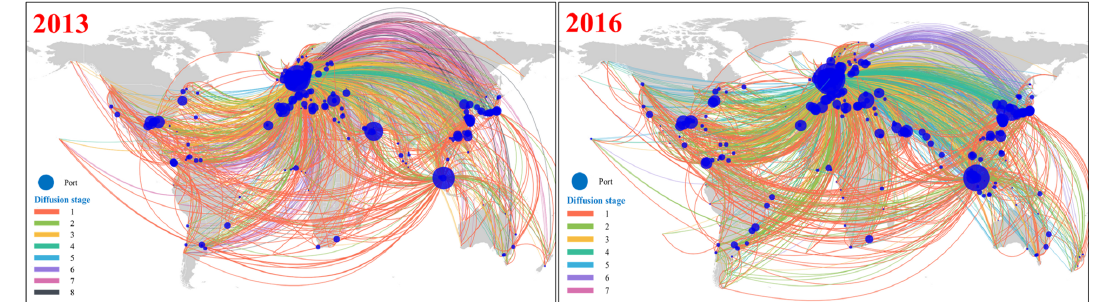
Figure 8. Hub influence and diffusion in 2013 and 2016